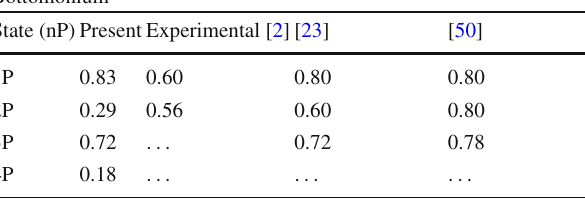
Table7 Theratiosofspin–orbitsplittings(R)forP-wavebottomonium and charmonium Bottomonium